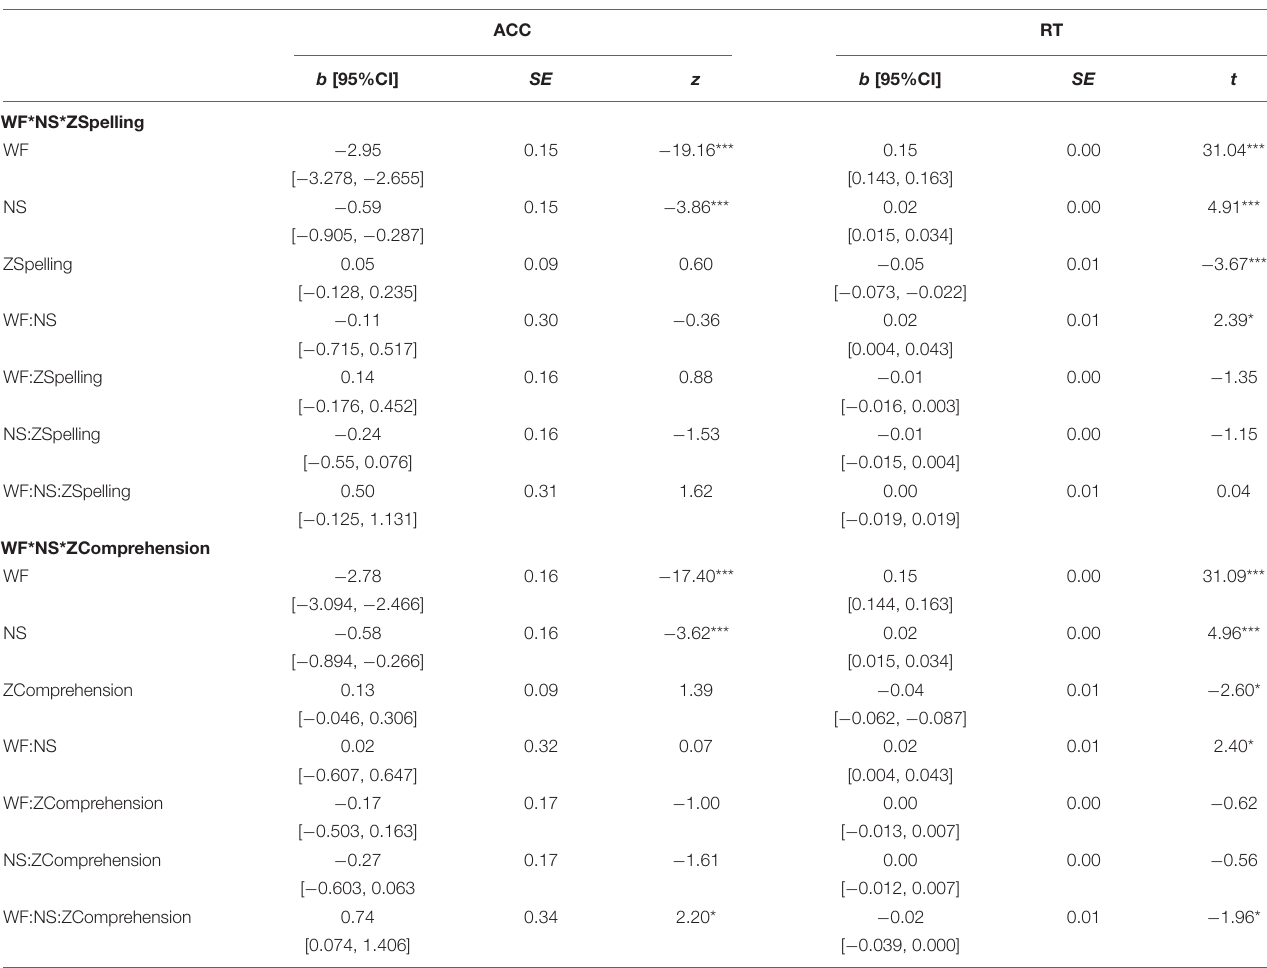
TABLE 5 | The results of GLMM/LMM models of individual difference.